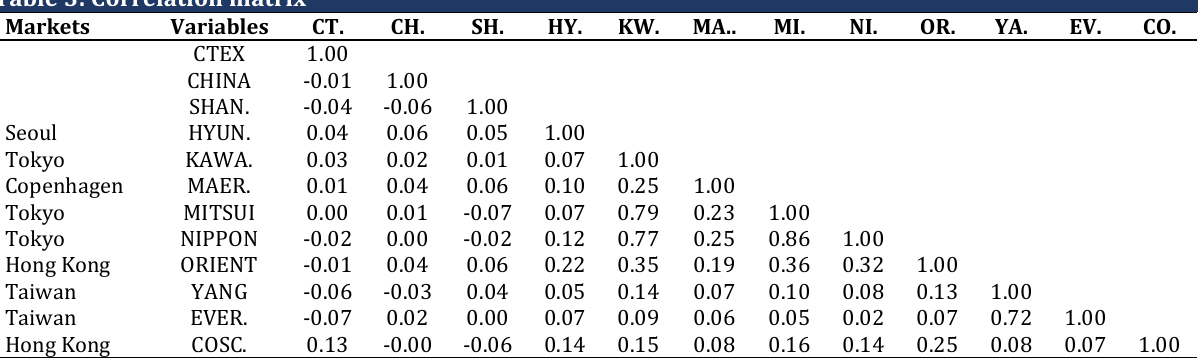
Table 3: Correlation matrix Markets Variables CT. CH. SH. HY. KW. MA.. MI. NI. OR. YA. EV. CO.